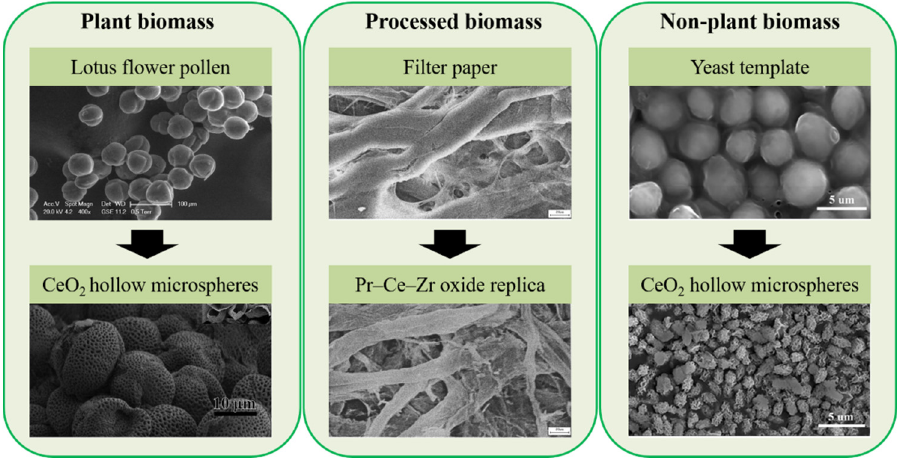
Figure 6. Classification of biological templates (adapted from [52,95,96]).